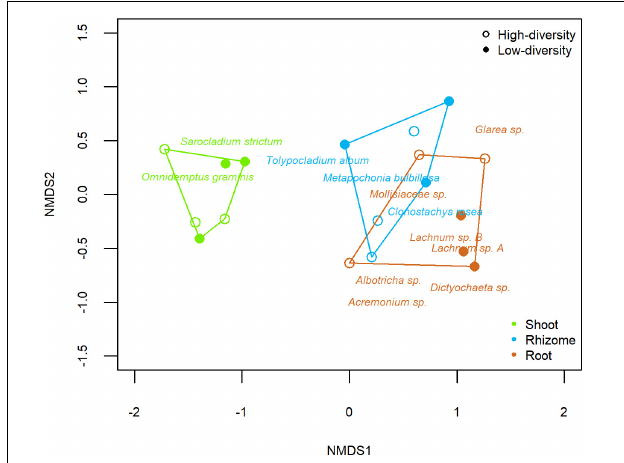
FIGURE 5 | Non-metric multidimensional scaling (NMDS) of the fungal endophyte community composition of tissues of Brachypodium rupestre from low and high-diversity grasslands.